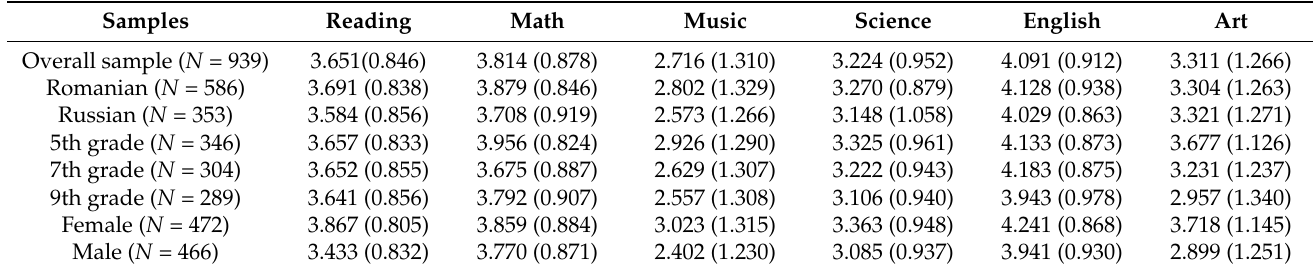
Table 1. Descriptive statistics: means and standard